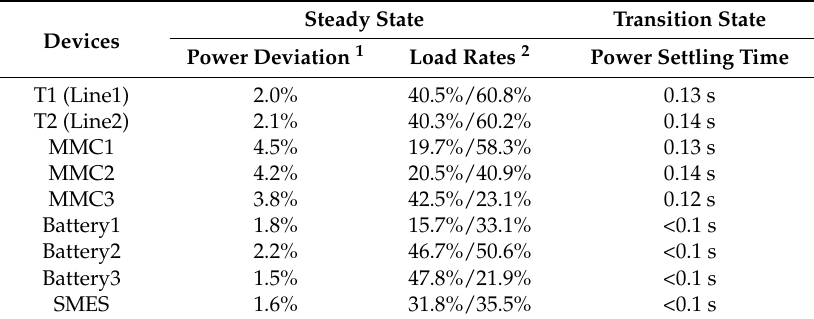
Table 4. Operation indexes during the normal operation of the HESS.